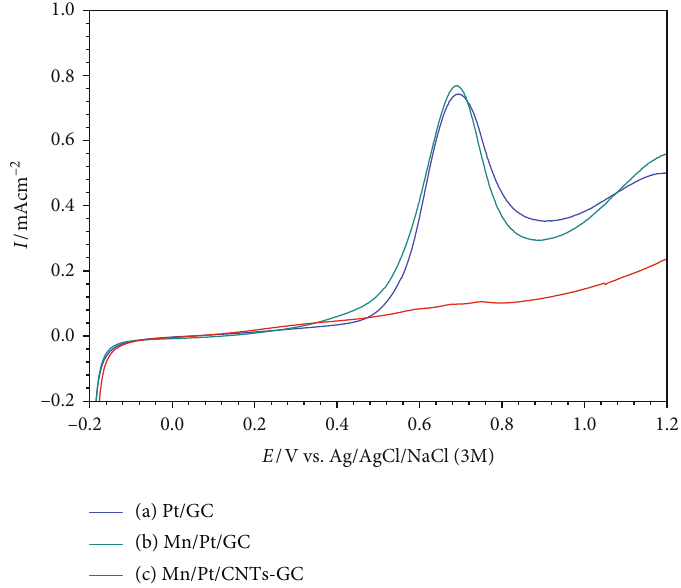
Figure 6: LSVs for oxidative CO stripping obtained at the (a) Pt/GC, (b) Mn/Pt/GC, and (c) Mn/Pt/CNT-GC electrodes in 0.5M Na ( pH = 3 : 5 ). Potential scan rate: 50 mVs -1 . Before measurements, CO was adsorbed from 0.5M FA at the open circuit potential for 10 min.